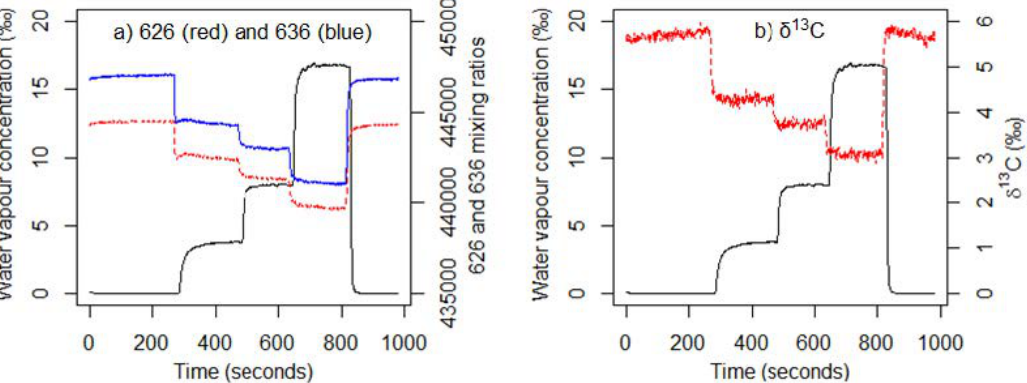
Figure 2. E ff ect of water vapour concentration on the measured mixing ratios of 626 and 636 and the resulting δ 13 C. ( a ) The e ff ect of water vapour concentration (black line) on measured 626 (red line) and measured 636 (blue line). ( b ) The e ff ect of water vapour (black line) on measured δ 13 C (red line). The